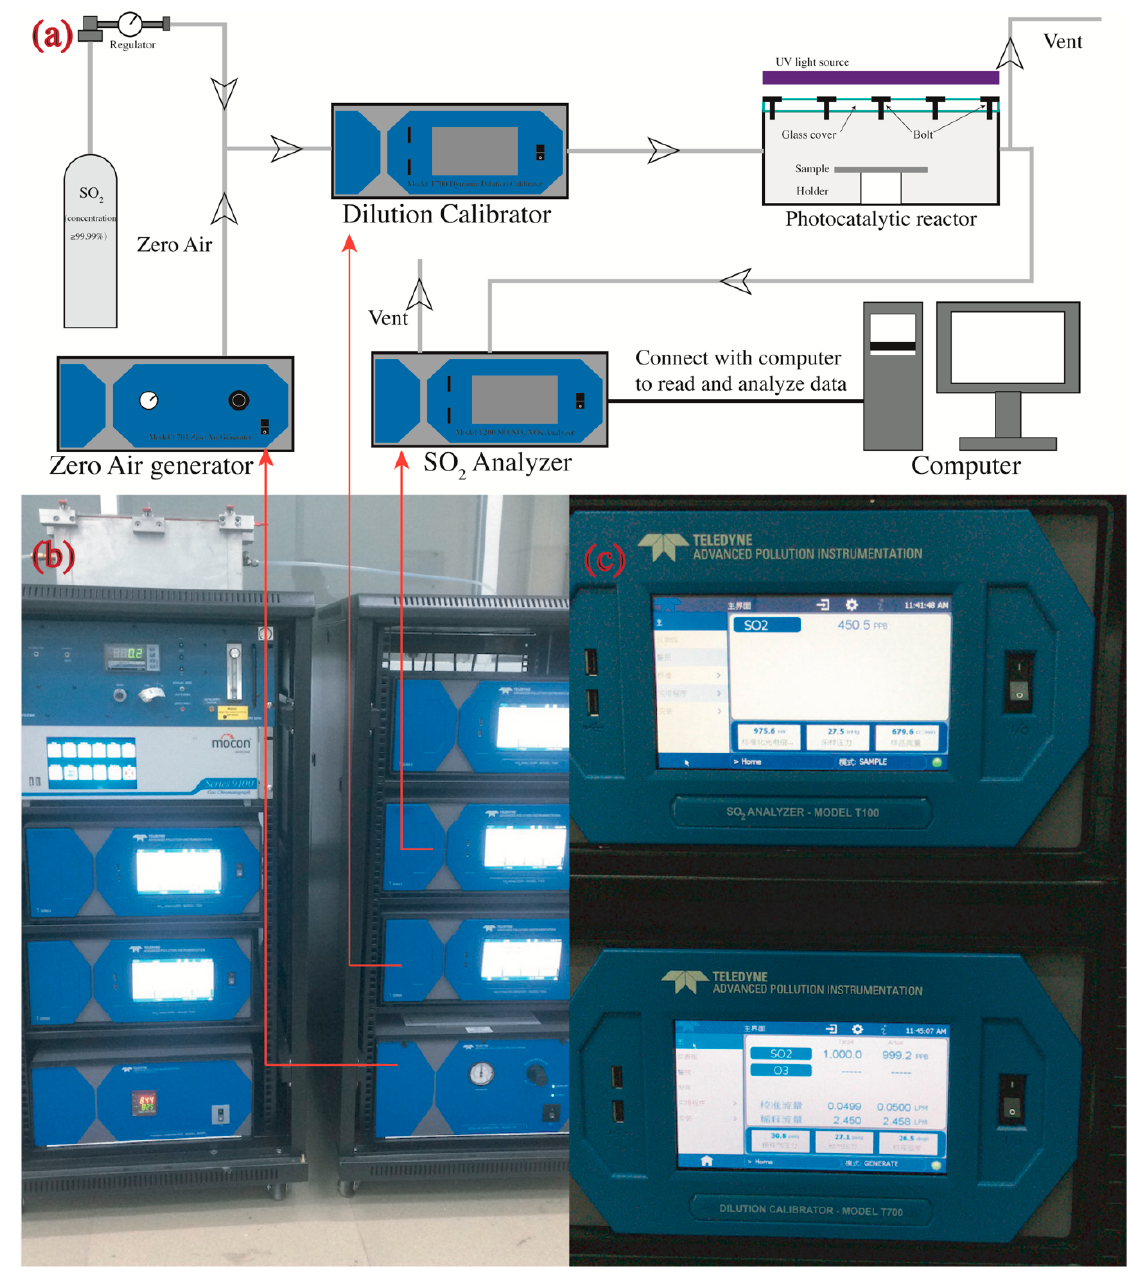
Figure 3. Photocatalytic instruments: ( a ) schematic diagram of measurement geometries (not to scale); ( b ) real picture of photocatalytic instruments; and ( c ) display panel of SO 2 analyzer (upper) and the dilution calibrator (lower).